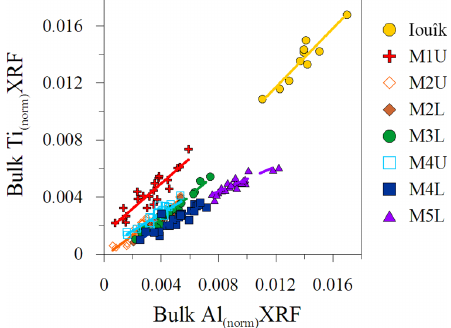
Figure 7. Comparison of bulk Ti and Al, normalized to total XRF counts for all seven sediment traps and the on-land dust collectors in Iouîk,